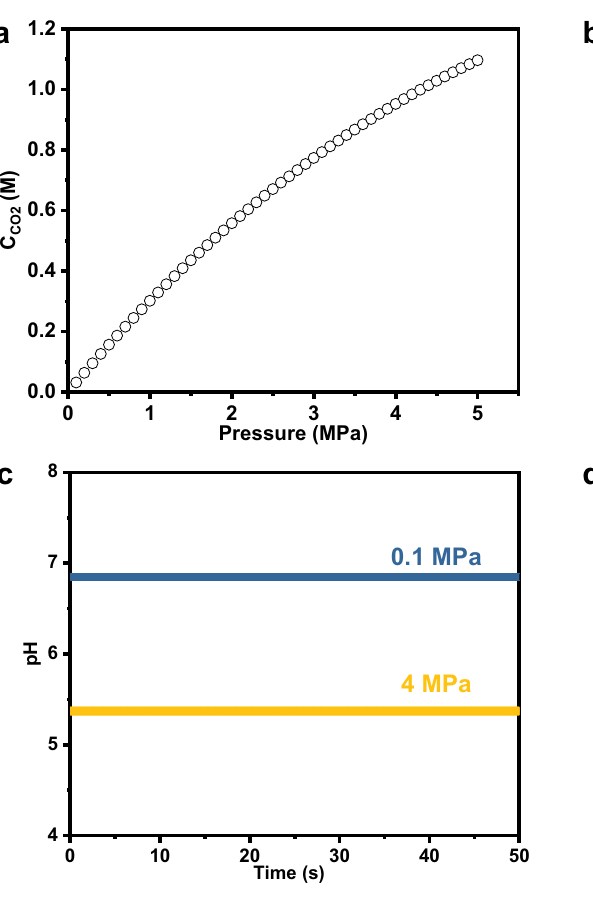
potentialof − 1.1Vvs.SHE)at c thebulkelectrolyteand d theelectrodesurfacewith CO 2 pressuresvaryingfrom0.1MPa(1atm)to4MPa(40atm).Errorbarsrepresent the standard deviation from at least three independent